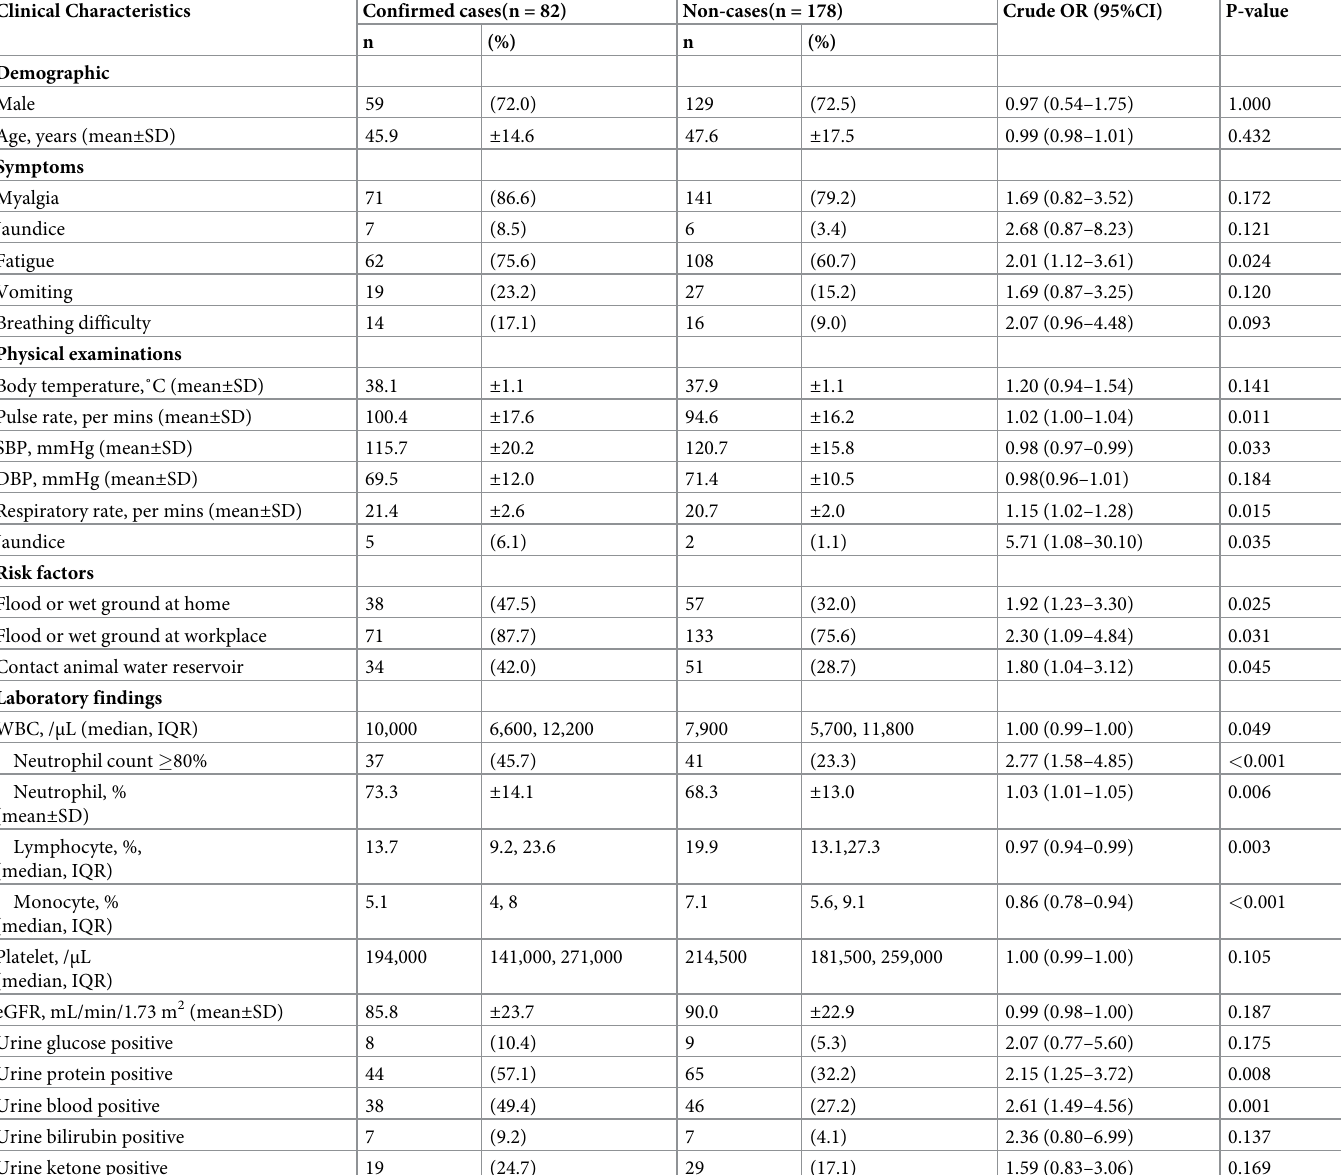
Table 1. Baseline demographic data, presenting symptoms, physical examinations and initial laboratory investigations of the derivation cohort, comparison of con- firmed-cases and non-cases of Leptospirosis . Clinical